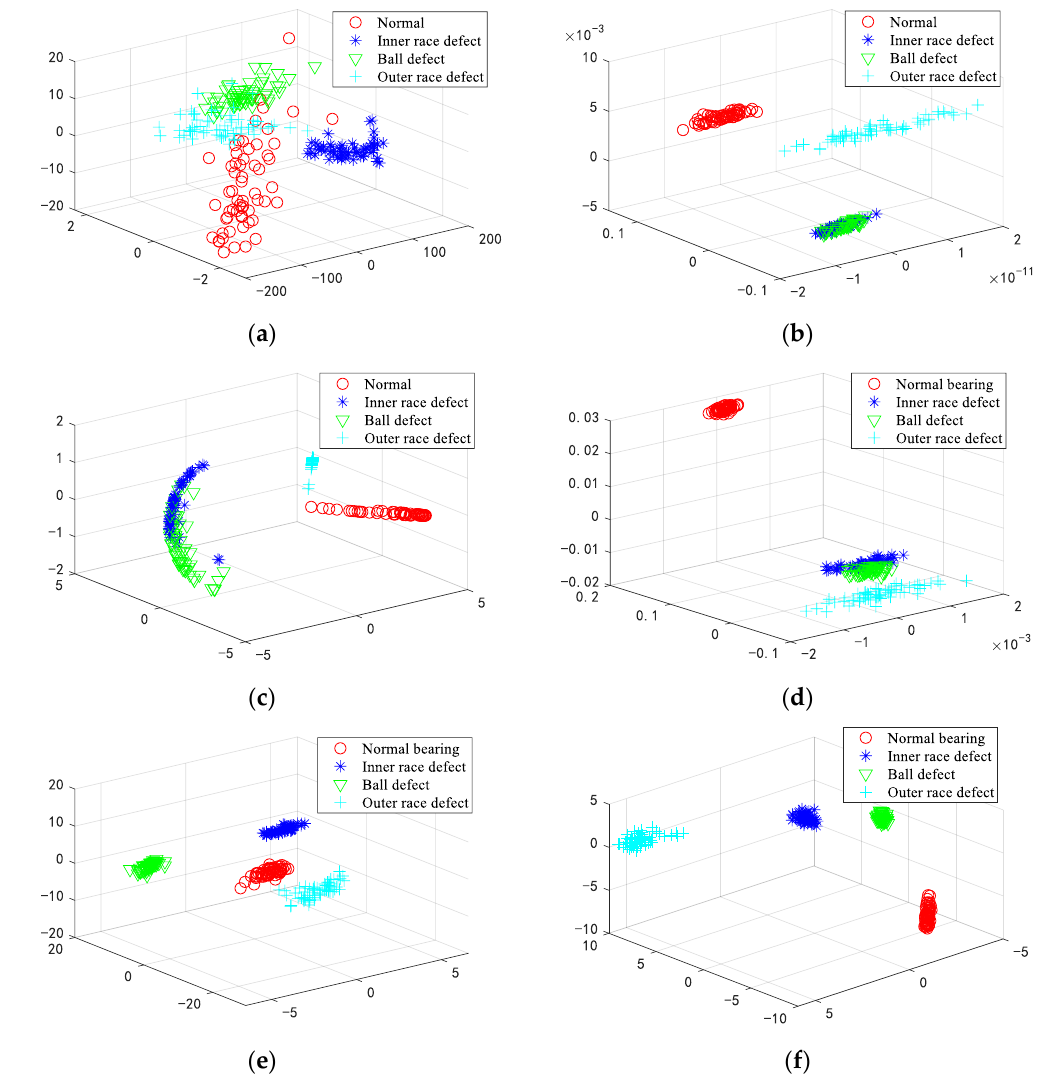
Figure 6. Three-dimensional distribution of test bearing samples: ( a ) LLE; ( b ) LPP; ( c ) KPCA; ( d ) OLGPP; ( e ) LSPD; ( f ) ESBDP.